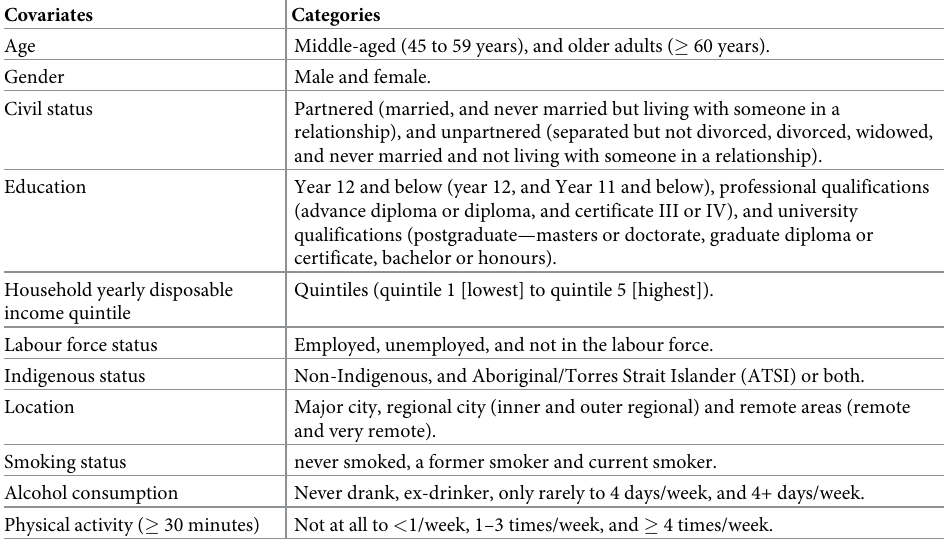
Table 1. Description of other